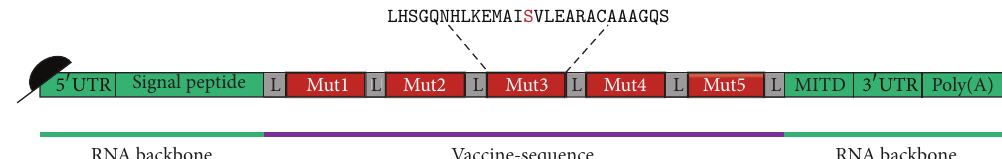
Figure 2: Structure of the pentatope RNA vaccine. Several modifications in the 5 󸀠 cap, 5 󸀠 and 3 󸀠 untranslated regions (UTR), poly(A) tail, and codon usage increased the translation efficiency and stability of the mRNA [30, 31]. Mutated sequences (Mut1–5) encoding 27 amino acids with the mutation in the center (red letter) are separated by nonimmunogenic 10mer linkers. The antigen encoding sequences are flanked by a signal peptide and the MHC class I trafficking domain (MITD, transmembrane, and cytoplasmic domain of MHC class I) to ensure optimal antigen presentation